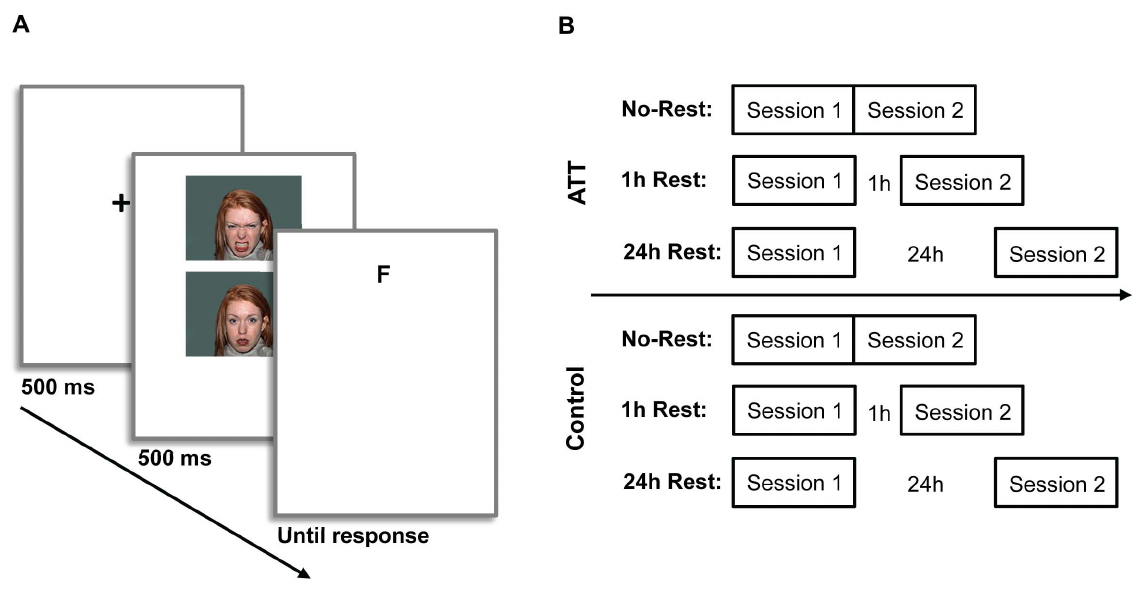
Figure 1. Trial sequence and experimental design. (A) Sequence of events in a single dot-probe trial: a fixation cross (500 ms) was followed by a face pair presentation (500 ms), and a probe (the letter E or F ) appearing in the space vacated by one of the faces (until response); (B) Six experimental groups were used, reflecting a 2-by-3 design of Training Condition (ATT, Control) by Rest Duration between Session 1 and 2 (No-Rest, 1 Hour, 24 Hours). ATT=attend-threat